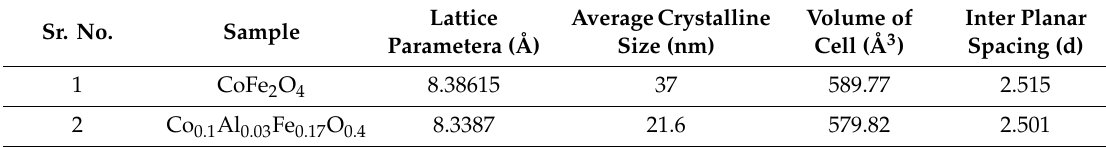
Table 1. XRD results of CoFe 2 O 4 and Co 0.1 Al 0.03 Fe 0.17 O 0.4 .